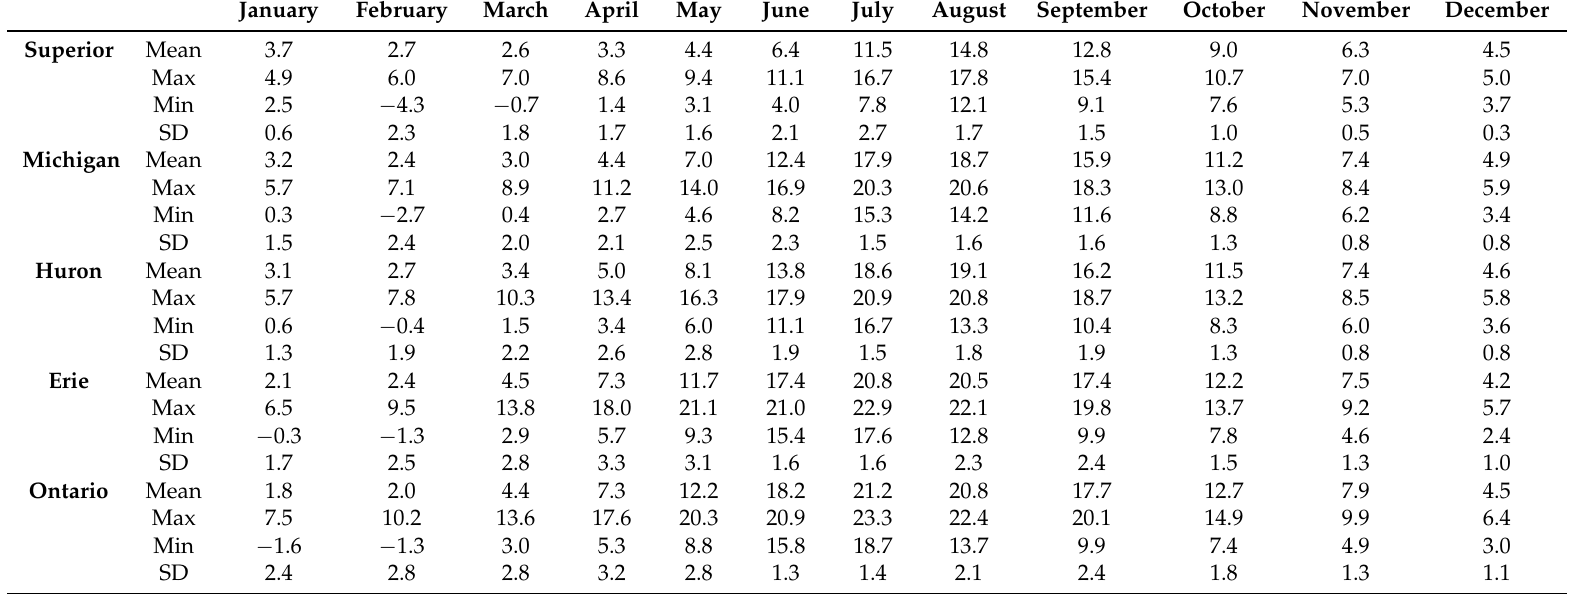
Table 2. Monthly mean GLST of each lake ( ˝ C) observed from July 2001 to December